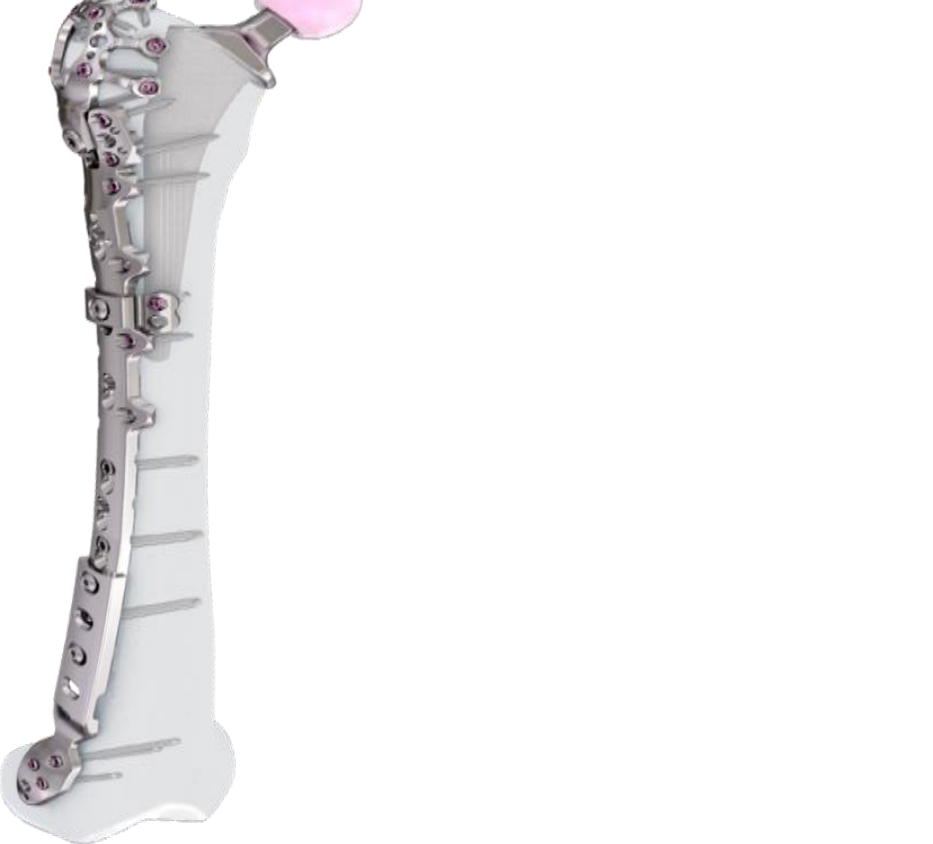
Figure 1. The 3.5/4.5 Variable Angle LCP ® Periprosthetic Proximal Femur Plating System by Depuy- Synthes from [20]. (Reprinted with permission from [20] 2021 Depuy-Synthes).